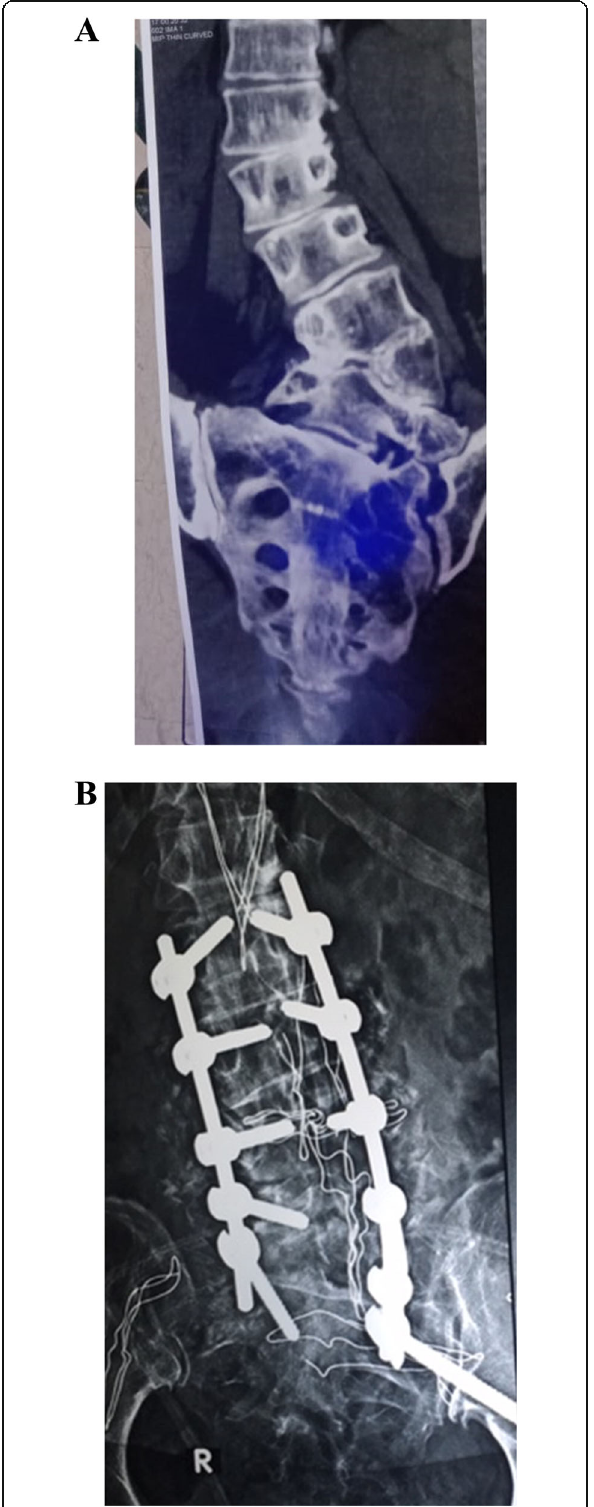
Fig. 2 a Preoperative LSS CT scan showing a case of congenital scoliosis in a 55-year-old female patient with a left-sided hemivertebra in between L4 and L5. b Immediate postoperative plain X-rays after removal of the hemivertebrae and partial correction with lumbopelvic fixation at one